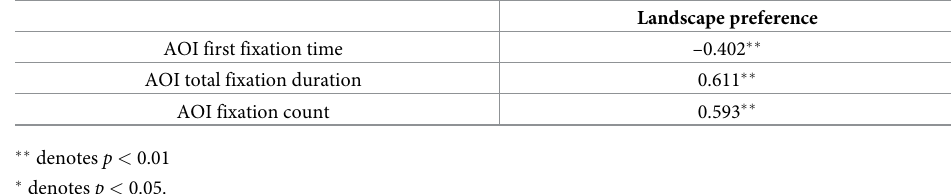
Table 4. Pearson correlation coefficient between visual behavior and landscape preference.